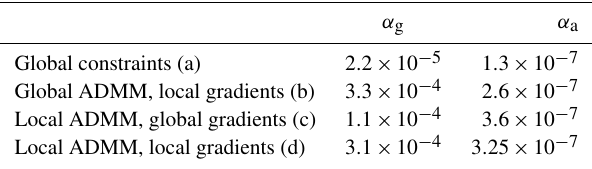
Table 3. The α values derived for simultaneous usage of global and local smoothness and ADMM bound constraints. Cases (a) through (d) correspond to cases (a) through (d) in Fig.